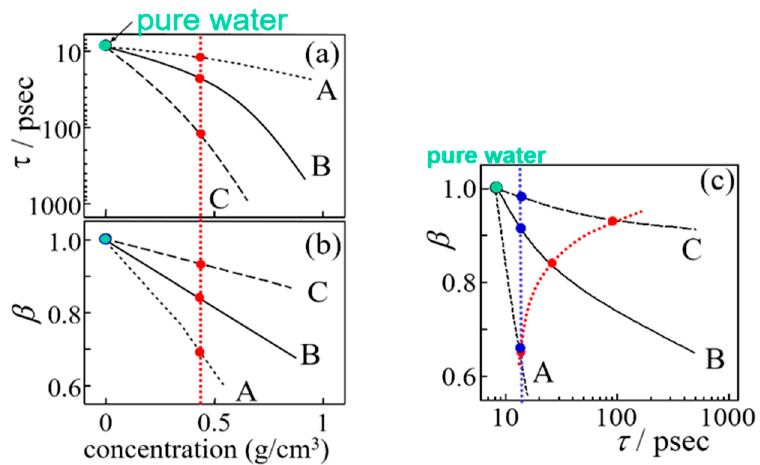
Figure 3. Examples of concentration dependences of ( a ) the relaxation time and ( b ) the relaxation time distribution parameter for model materials, A, B, and C. ( c ) The relaxation time dependent of its distribution parameter for same model materials. Red and blue dotted lines express ideas of the conventional and the present analyses, respectively.